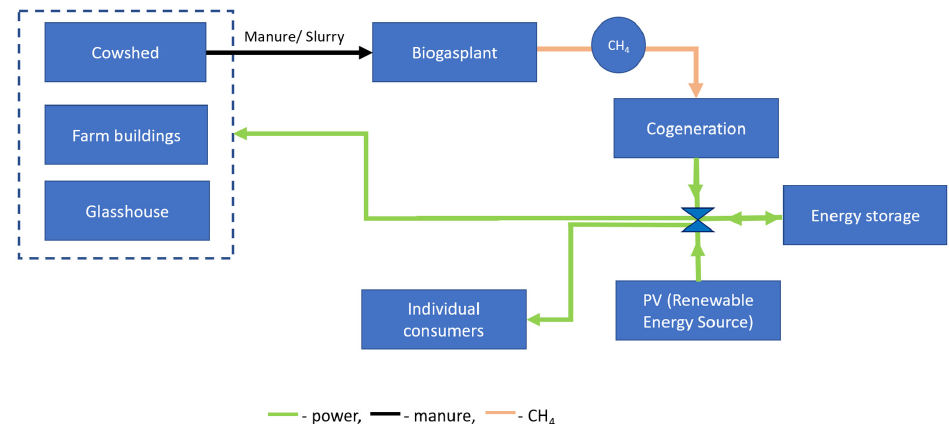
Figure 2. Diagram of electric power flow produced on a medium-sized cattle farm with an off-grid solution, an energy storage unit, and a smart valve supporting energy routing.